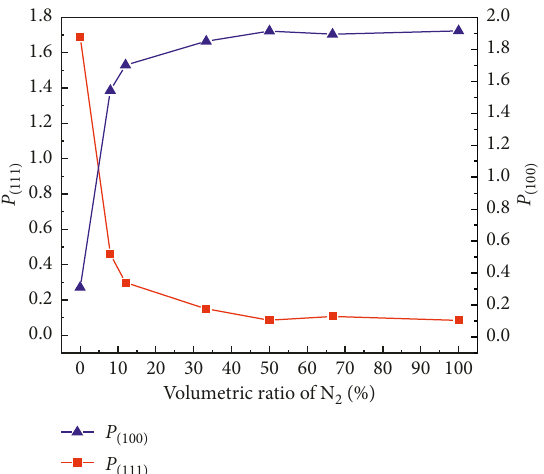
Figure 3: P (111) and P (100) of silver thin films on Si substrates as a function of the volumetric ratio of N 2 content.